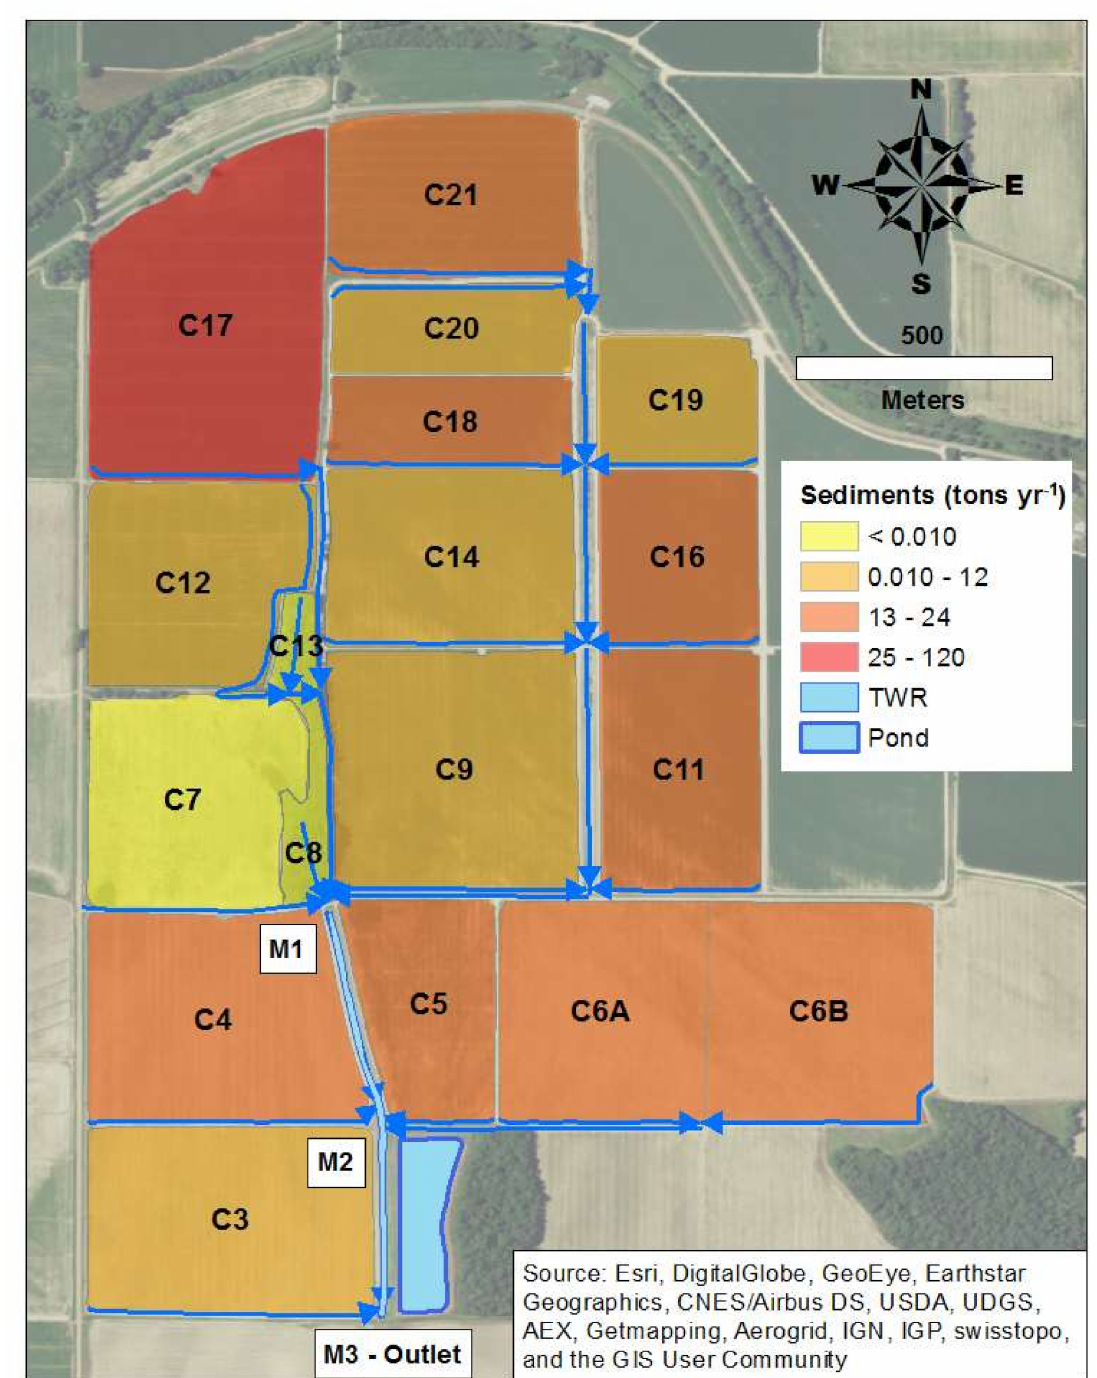
Figure 6. Map of the study area showing the average annual sediment load in the simulated watershed. The blue arrows represent the runo ff flow direction towards the outlet. (M1: TWR inlet; M2: TWR mid-canal; M3: TWR outlet; labels within fields indicate the subwatershed identification used by the AnnAGNPS